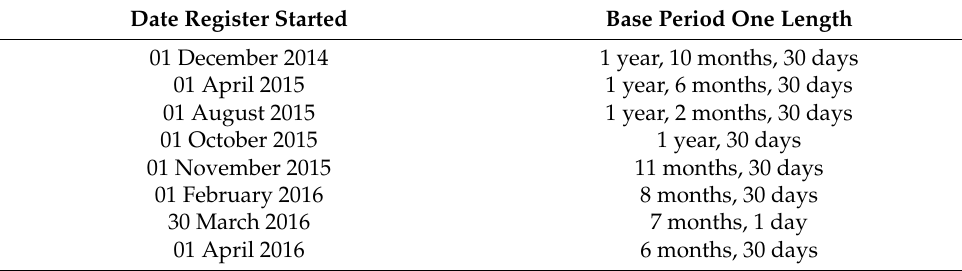
Table 5. Base period one Register